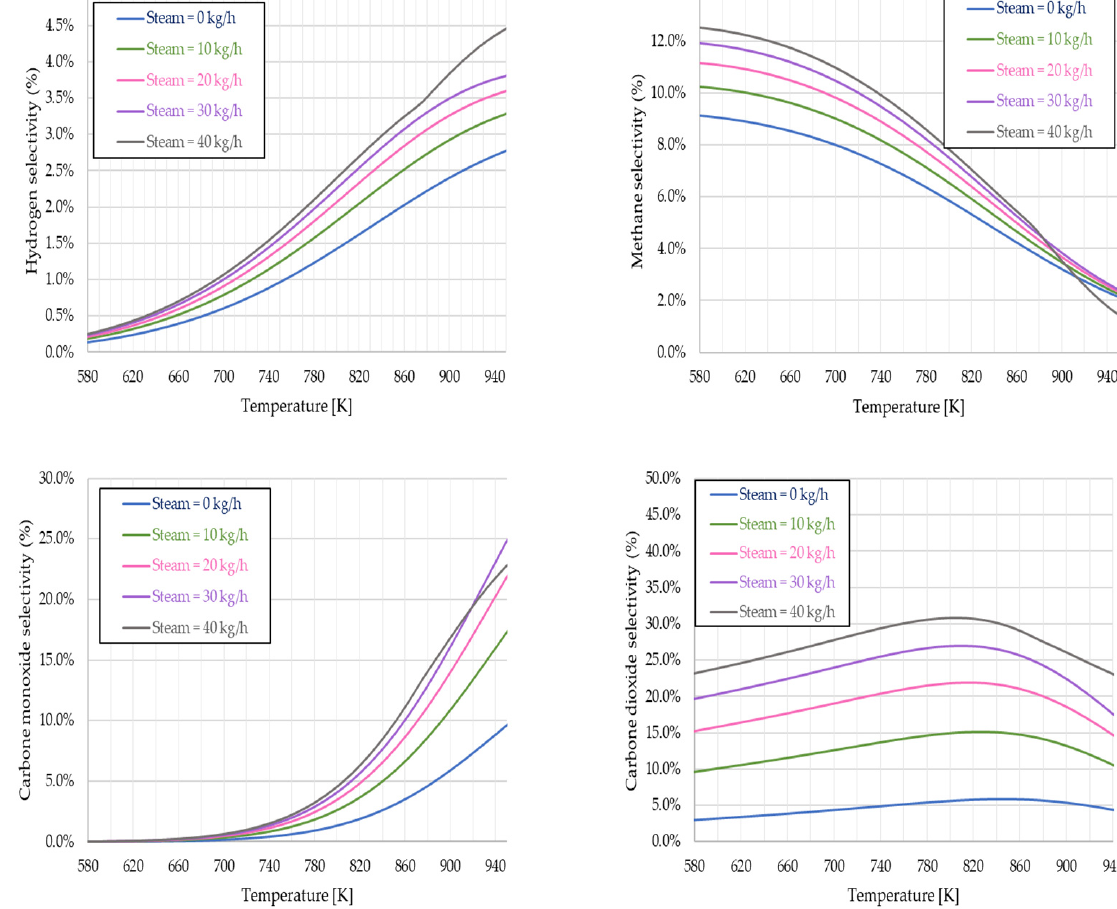
Figure 10. The effect of temperature over components selectivity for different steam streams (a feed stream of 100